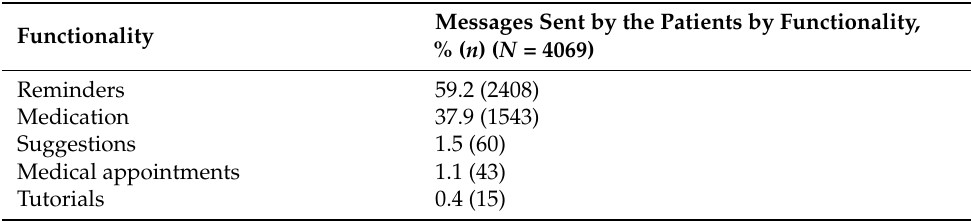
Table 4. Analysis of the